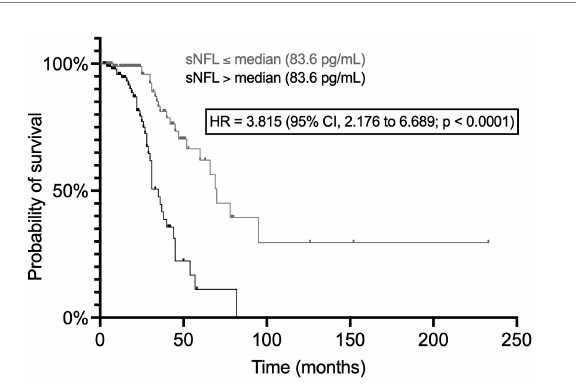
FIGURE 8 Association of serum NFL levels with survival. The two Kaplan–Meier curves refer to patients with sNFL levels ≤ and > the median value, respectively. CI, confidence interval; HR, hazard ratio; NFL, neurofilament light chain; sNFL, serum neurofilament light